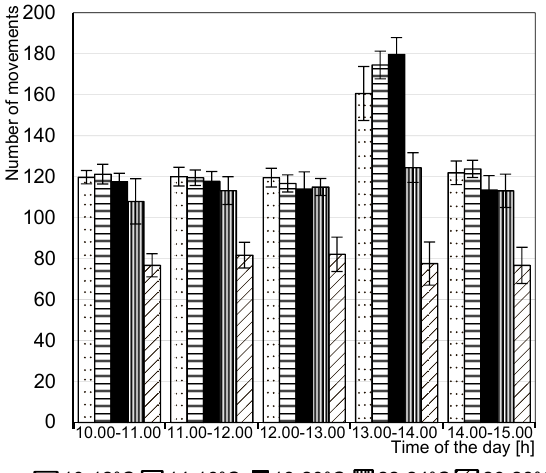
Fig. 2. Movements of round goby, Neogobius melanostomus (mean ± standard deviation) during one hour with normal atmospheric pressure (10:00–11:00 h,